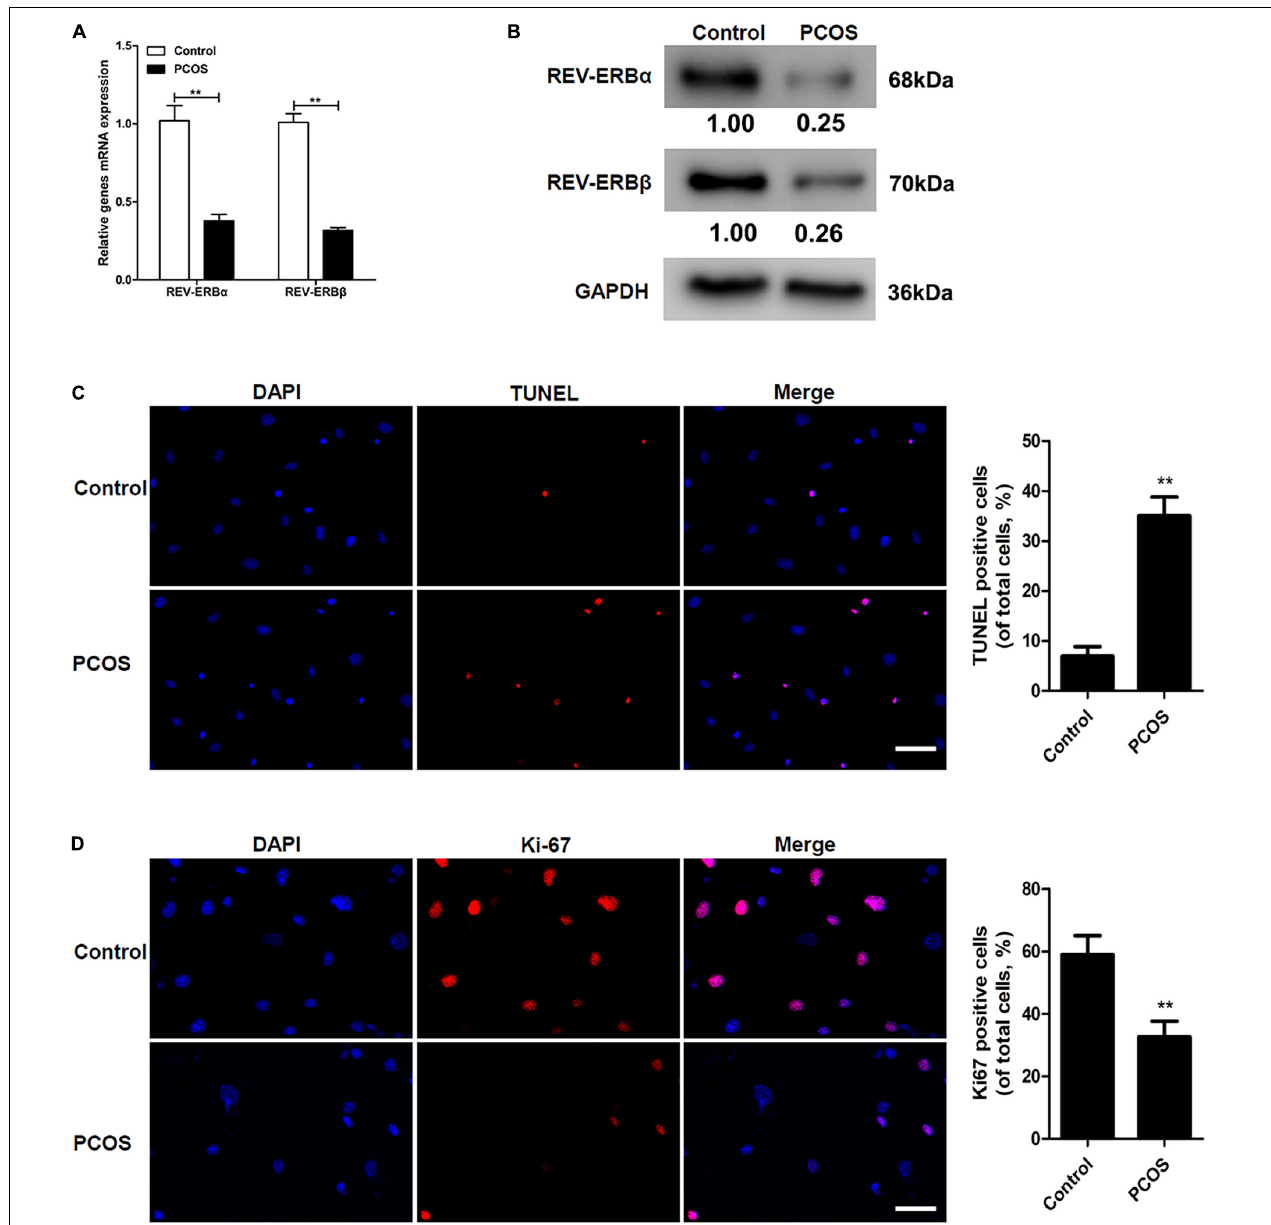
FIGURE 1 | Comparison of REV-ERBs in the granulosa cells of PCOS patients. (A,B) REV-ERB levels in granulosa cells were detected by qRT-PCR and western blot analysis. (C) Granulosa cell apoptosis assayed by TUNEL, and the percentage of positive cells. (D) Granulosa cell proliferation (Ki67-positivity) was assessed by immunofluorescence, and the percentage of positive cells. Scale bars: 50 µ m. Blue fluorescence represents DAPI staining; Red fluorescence represents Ki-67 expression. Data are presented as means ± SEM. ** P < 0.01 vs.